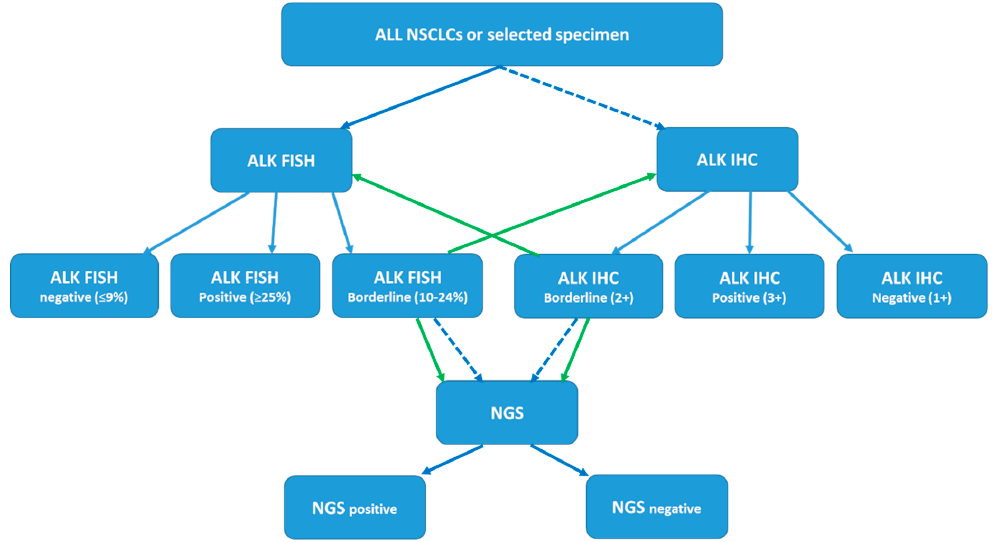
Figure 2. Proposed diagnostic algorithm for ALK status testing in lung cancer. For example, a specimen can be tested with ALK FISH (or ALK IHC) first. If a borderline result (either borderline negative or borderline positive) is obtained, the sample will be further tested with ALK IHC (or ALK FISH). If the ALK status is still uncertain, then targeted RNA-seq is applied and the final ALK status is determined based on the NGS result. For cases with discrepant results obtained by two methods, a third methodology, if available, should be applied to clarify the discrepancy. Solid blue arrow: proposed primary test methodology or predicted test results. Solid green arrow: proposed reflex test(s). Dashed blue arrow: alternative test methodology.